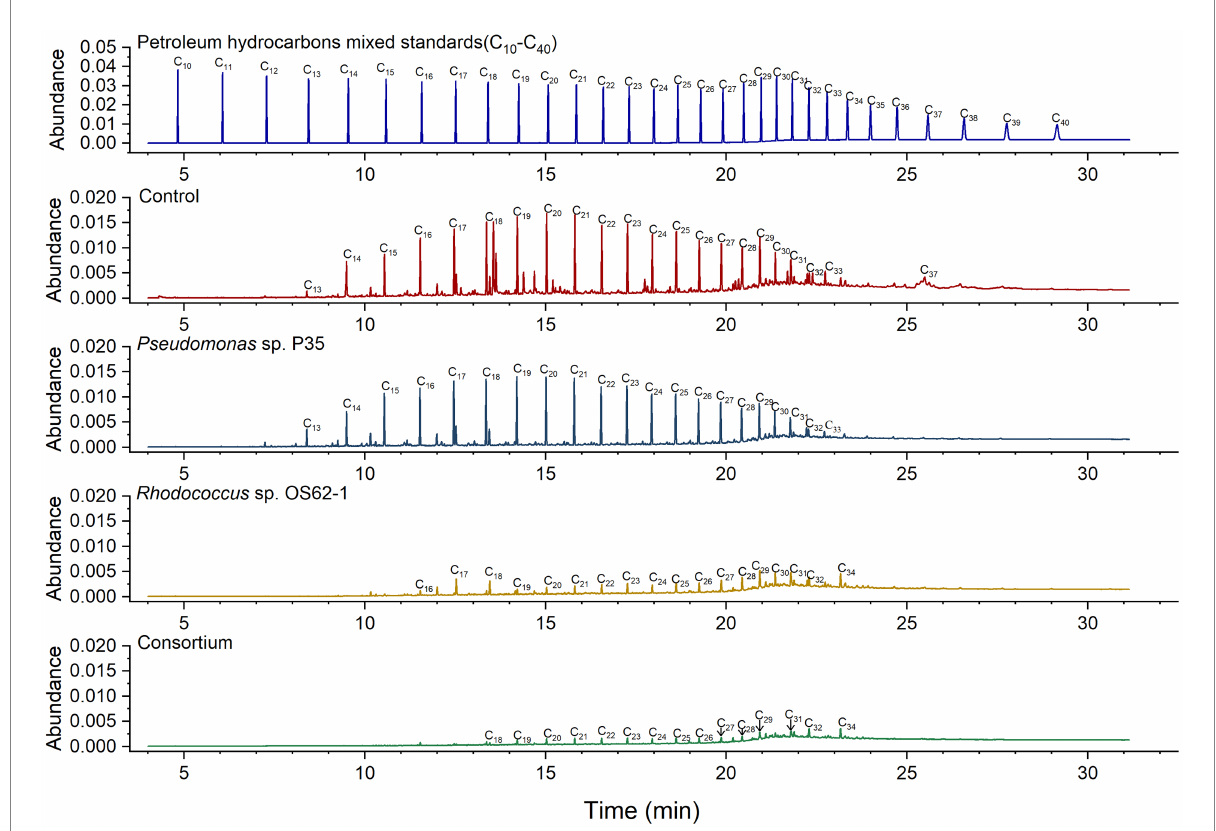
FIGURE 5 Gas chromatogram (GC) of biodegradation efficiency of saturated hydrocarbons in crude oil by single strain and consortium treatment in 7